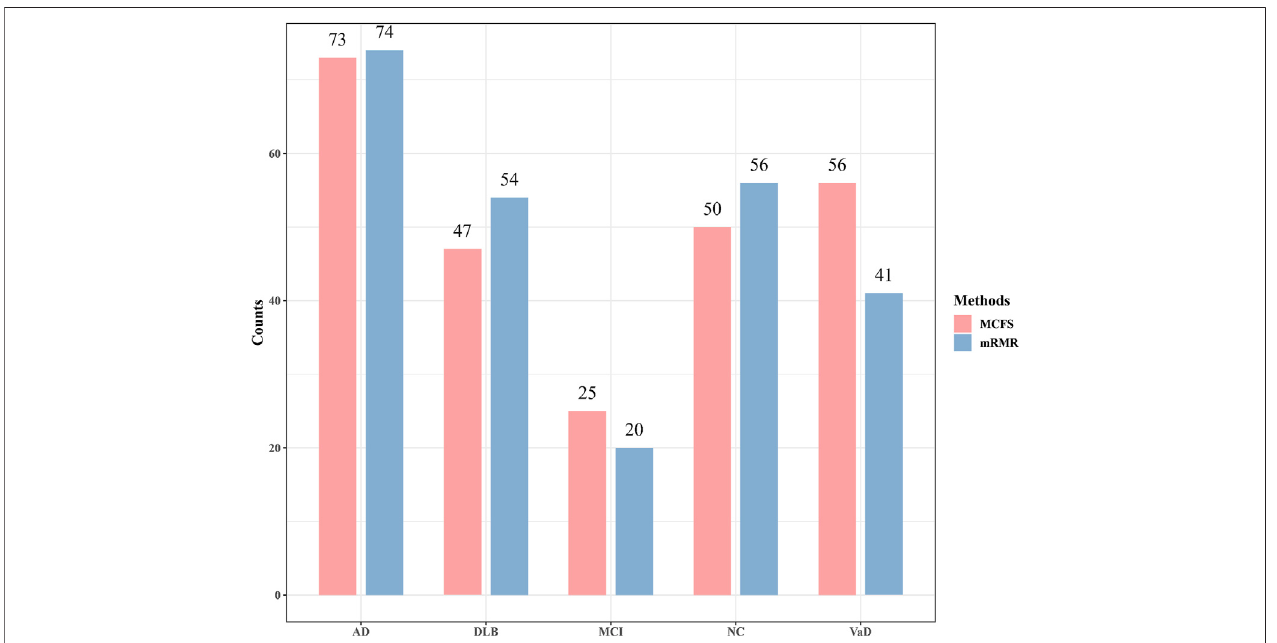
FIGURE5| NumberofrulesgeneratedbytheoptimalPARTclassi fi ersbasedonmRMRandMCFSfeaturelists.AD,VaD,DLB,MCI,andNCstandforAlzheimer ’ s disease, Vascular dementia, Dementia with Lewy bodies, Mild cognitive impairment and Normal control, respectively.